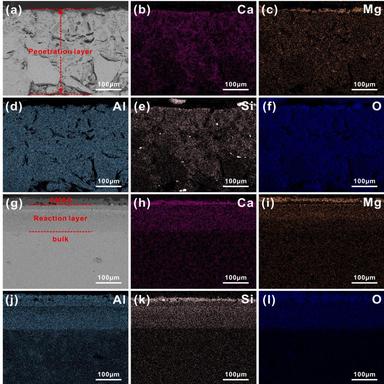
Elemental distribution maps in the cross section of (Y1-xLax)3Al5O12 samples after CMAS corrosion at 1250 ◦C for 10 h: (a)–(f) x = 0, (g)–(i) x = 0.2.